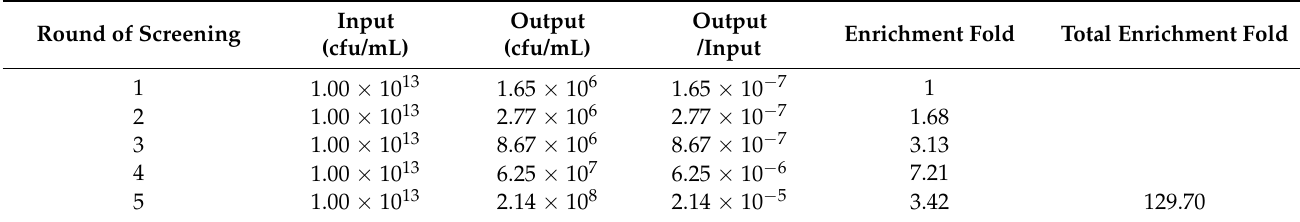
Table 1. The enrichment of scFv phage display library targeting LukE.